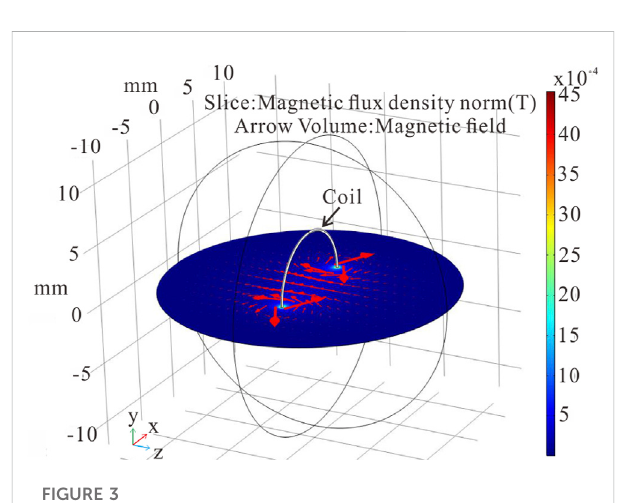
FIGURE 3 3D drawing of the magnetic fi eld in the energizing